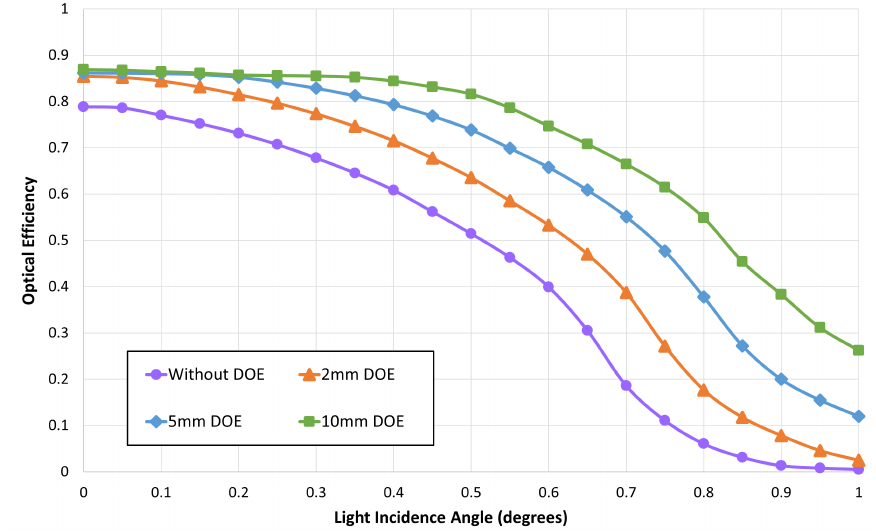
Figure 3. Angular efficiency curves for the different optical configurations studied. DOE: diffractive optical element.